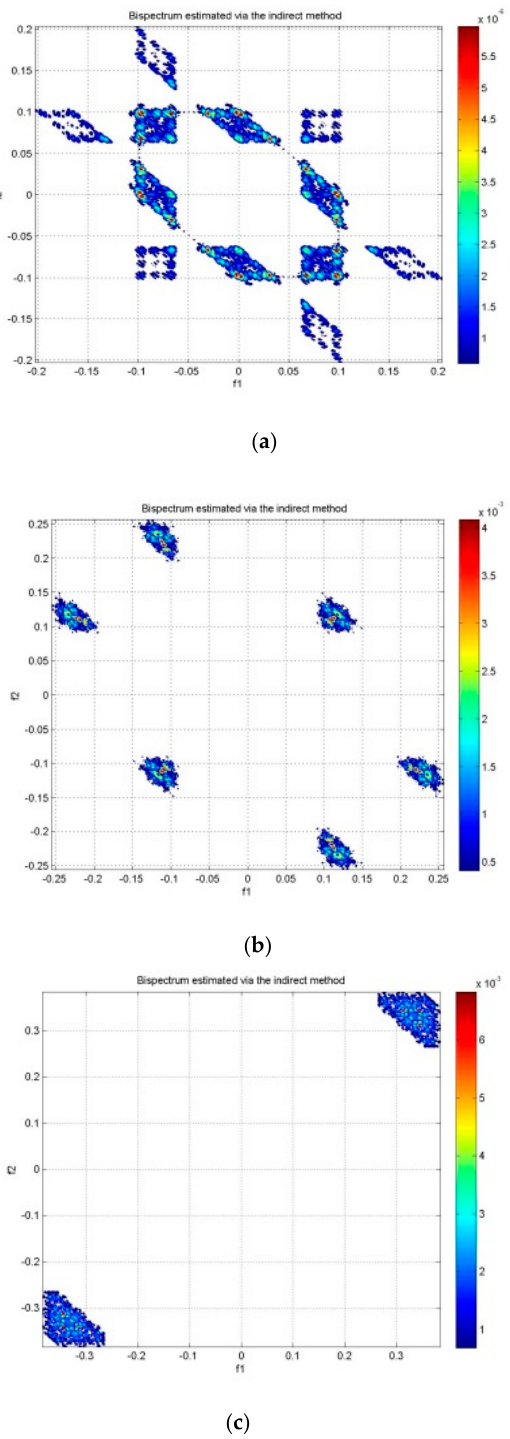
Figure 4. Bispectrum contour plot of LBD anger emotion in ( a ) alpha band, ( b ) beta band, and ( c ) gamma band .